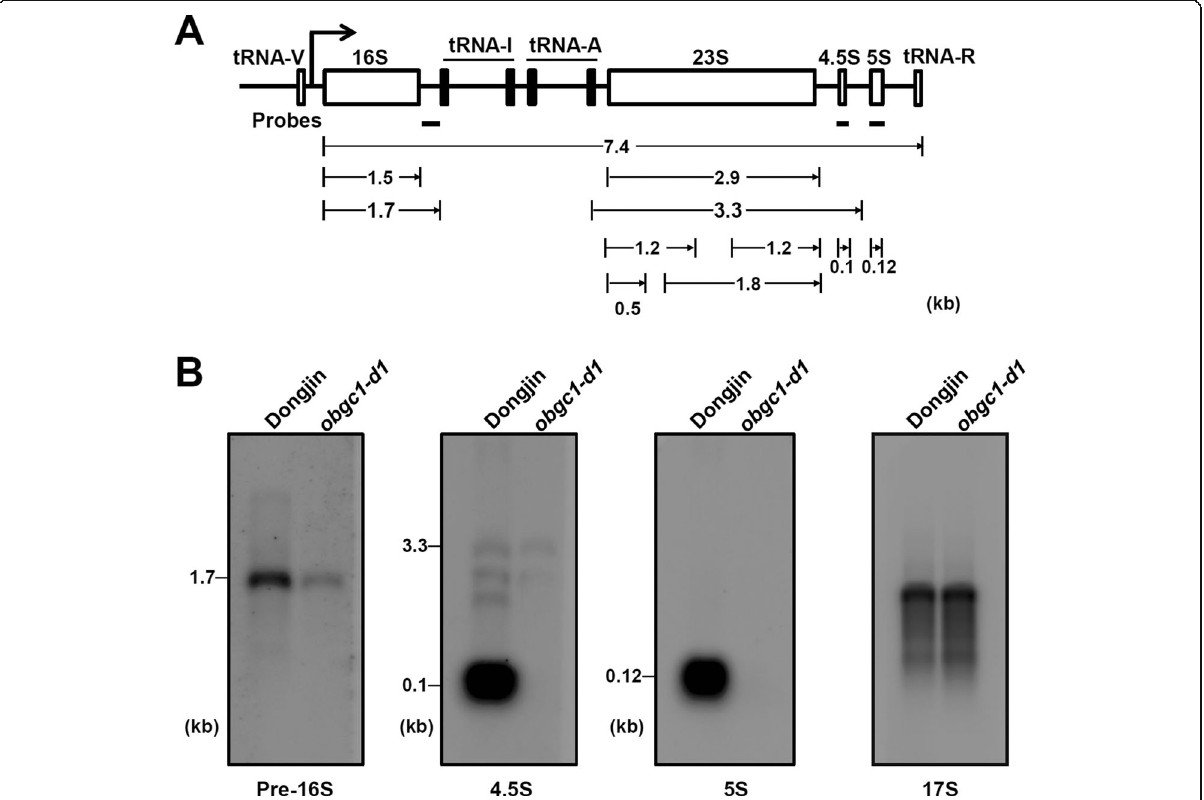
Fig. 10 Analysis of plastid rRNA processing in the obgc1-d1 mutant. A A diagram of rice plastid rRNA operon. The probes used in the RNA gel blot analyses in ( B ) are shown as thick black lines under individual rRNA genes. B RNA gel blot analysis. One microgram of total RNAs from wild- type (Dongjin) or obgc1-d1 mutant was loaded and separated in 1.2% agarose-formaldehyde gels, and blots were probed with specific gene sequences to detect processed plastid precursor rRNAs. The cytosolic 17S rRNA shown in the 4th gel image was used as a loading or negative